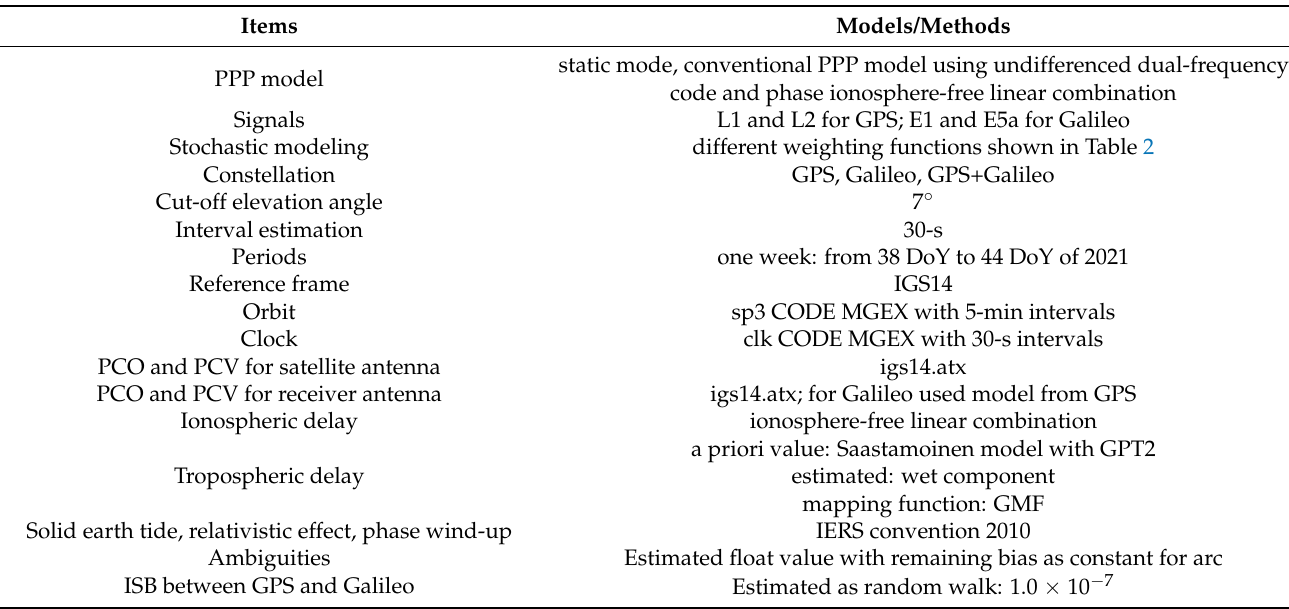
Table 1. Methods and models used.